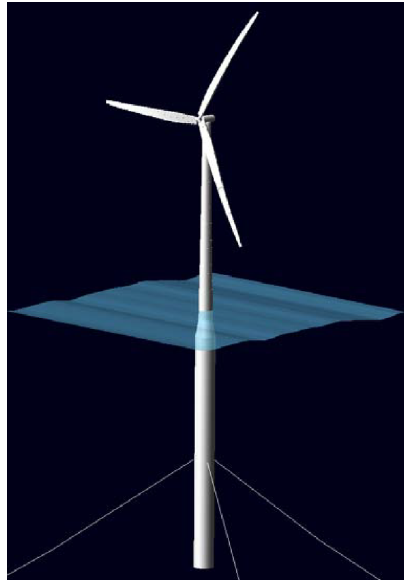
Figure 2. Model of the OC3 spar-buoy floating offshore wind turbine (FOWT) system; Reprint with permission [8]; 2010, NREL.